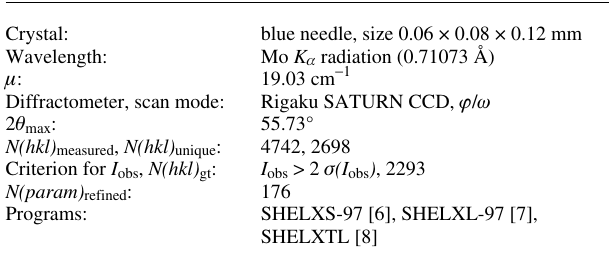
Table 1. Data collection and